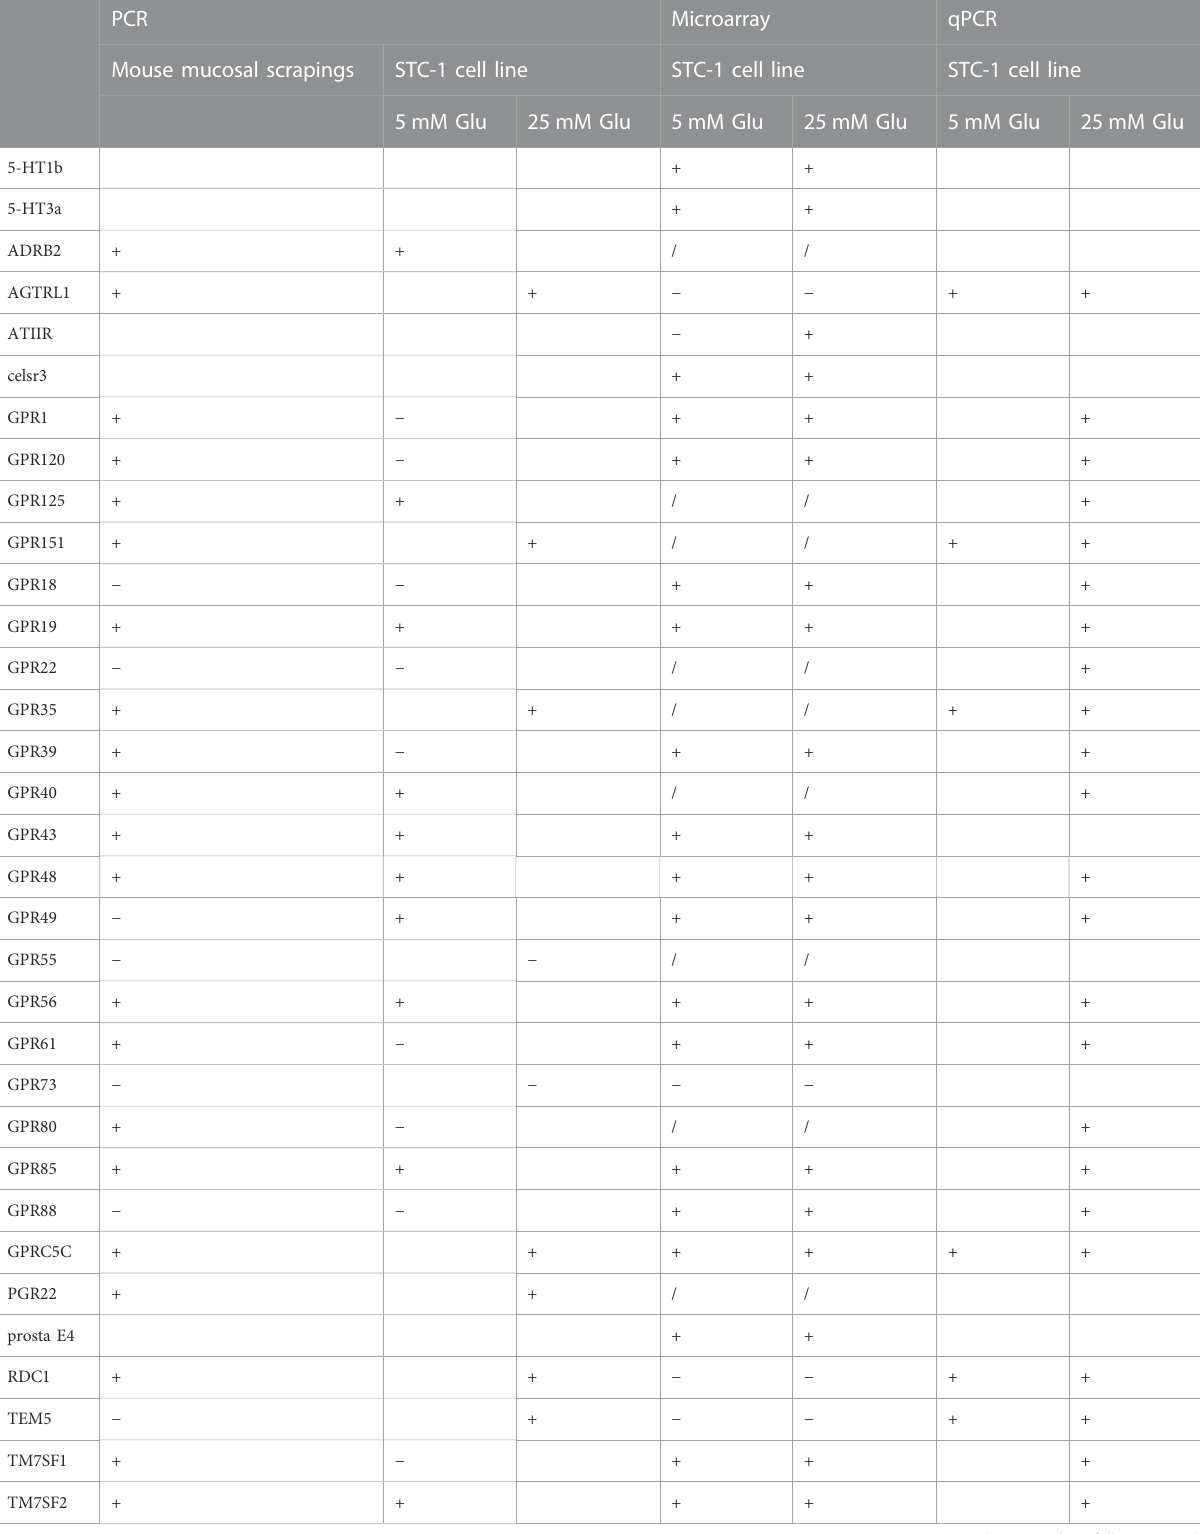
TABLE1GPCRswhoseexpressionwasdetectedinmouseproximalduodenalmucosalscrapingsorintheintestinalSTC-1celllineculturedinmediumwith5or 25 mM glucose for the last 24